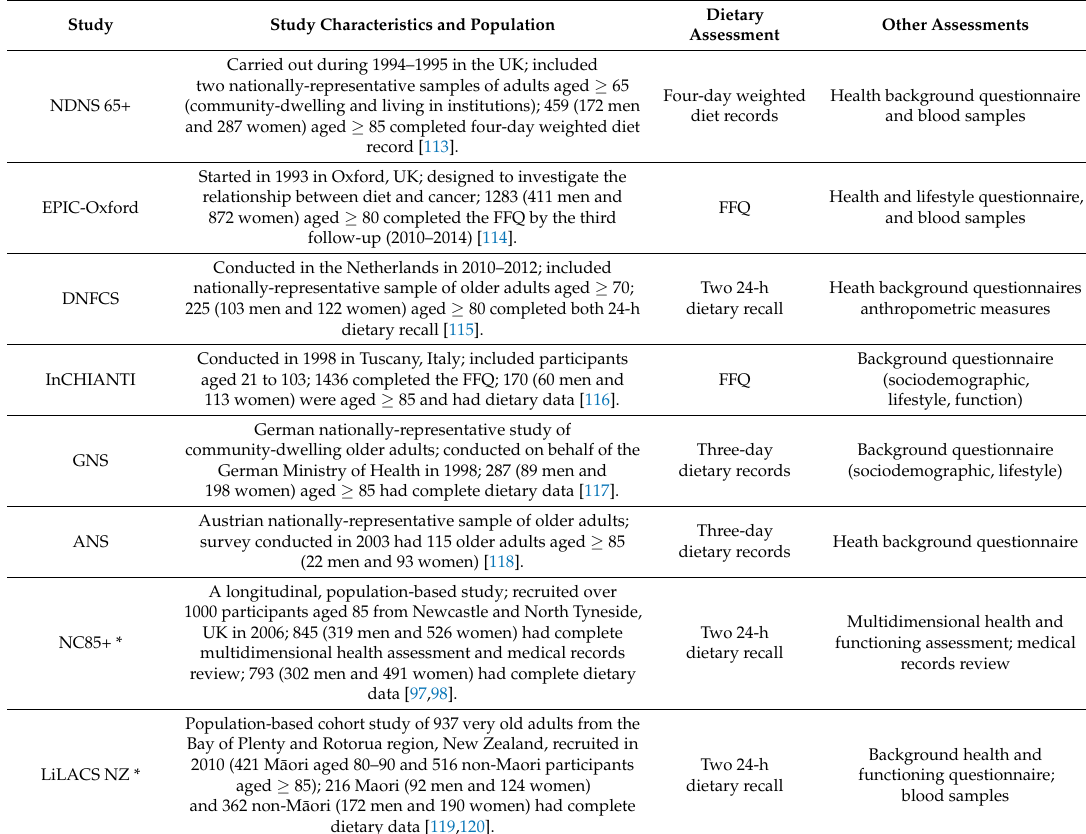
Table 1. Characteristics of the European studies including the very old and the very old specialized cohorts *.